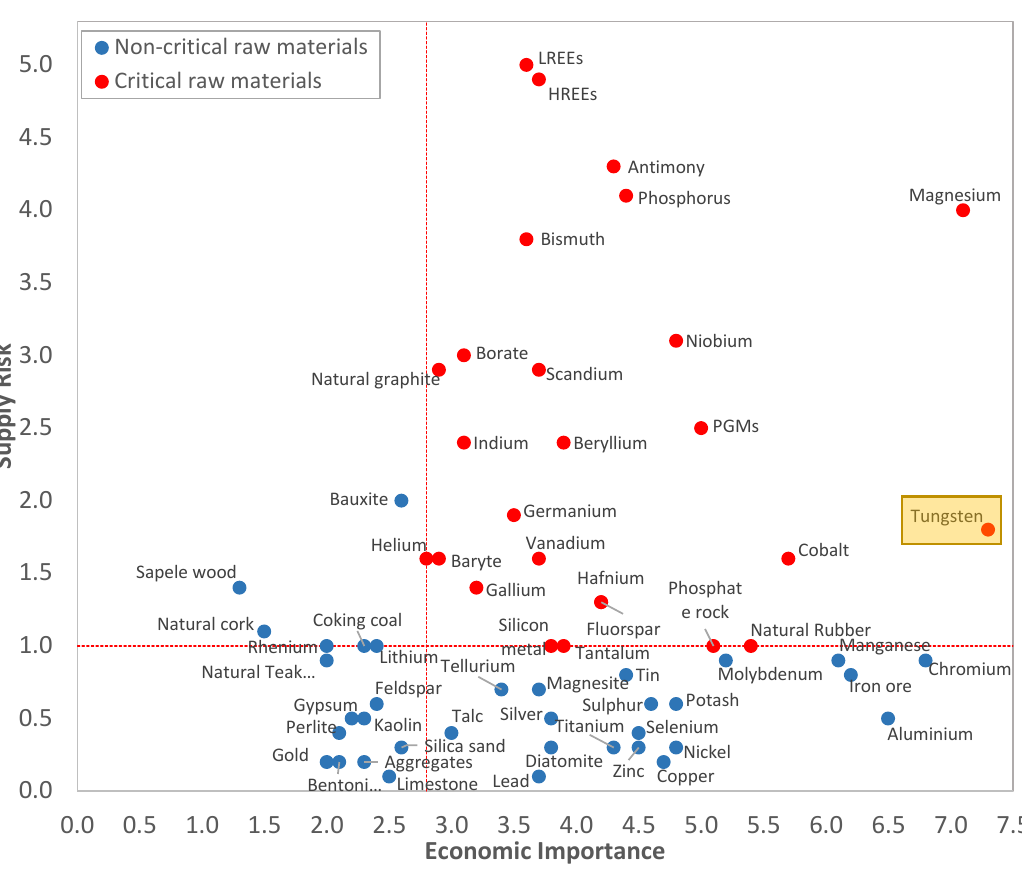
Figure 1. European Commission criticality assessment for raw materials with critical materials highlighted in red, tungsten has been further highlighted by the authors [1].